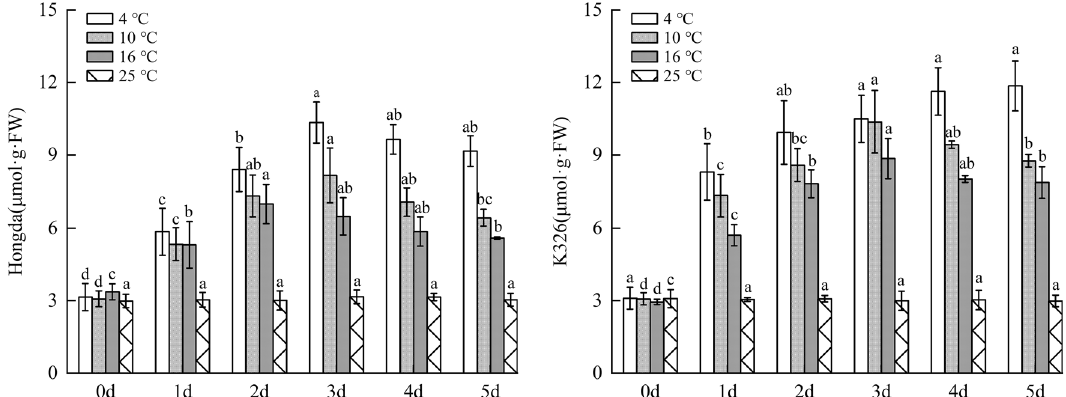
Figure 4. The changes of MDA content under different low-temperature stresses. Note: Different lowercase letters indicated that there were significant differences at different times under the same temperature treatment (P < 0.05). The values were the mean of three biological replicates.